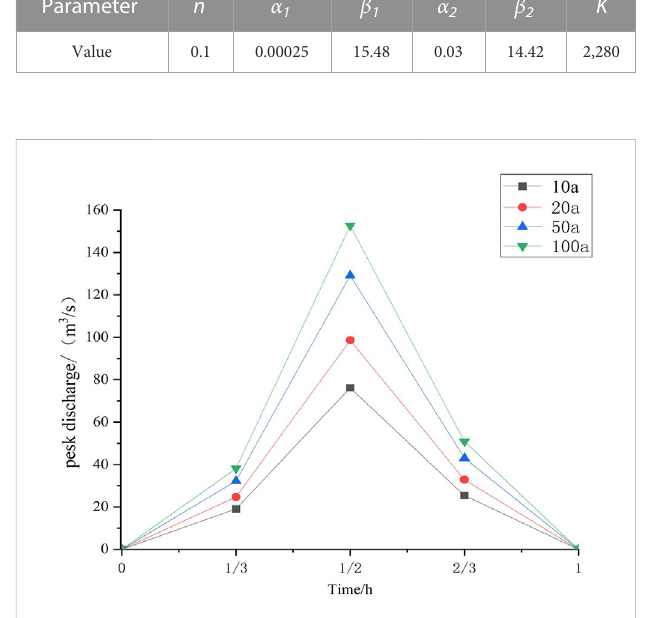
FIGURE 4 Variations of peak discharge of debris fl ow with time in Shaling